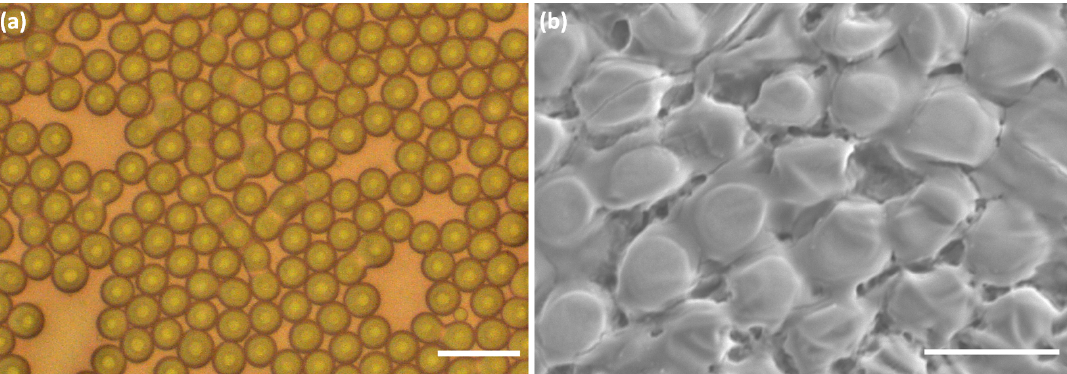
Figure 6. Optical ( a ) and SEM ( b ) micrographs of ZnO droplets stabilized by TB-Krytox surfactant. The observed merging process demonstrate the effect of screening charges of ZnO nanoparticles on the long term stability of zinc oxide droplets and particles. Scale bars: ( a ) 30 µ m; and ( b ) 20 µ